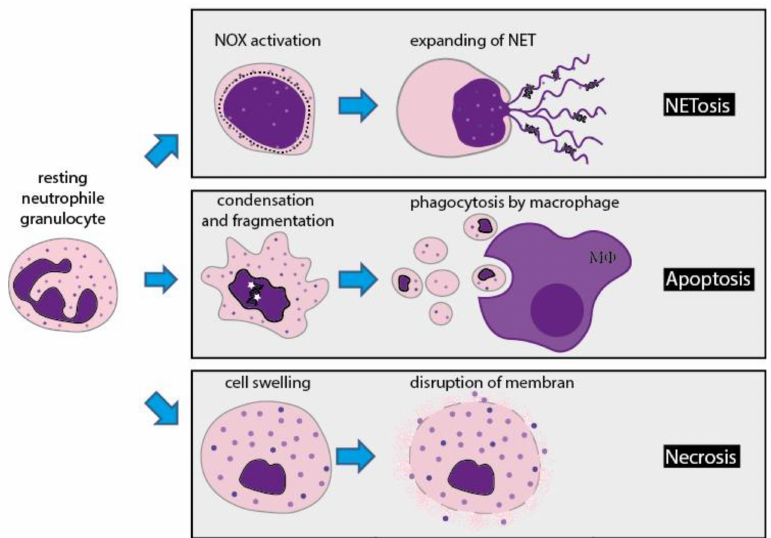
Figure 4. NETosis vs. apoptosis/necrosis. Three different pathways of cellular death of